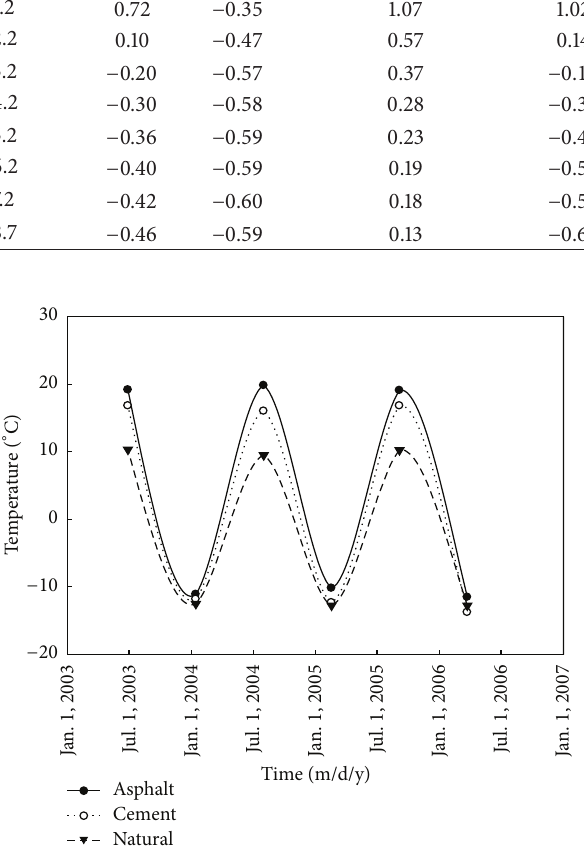
Figure 2: The curve of the surface temperature amplitude under different pavements.